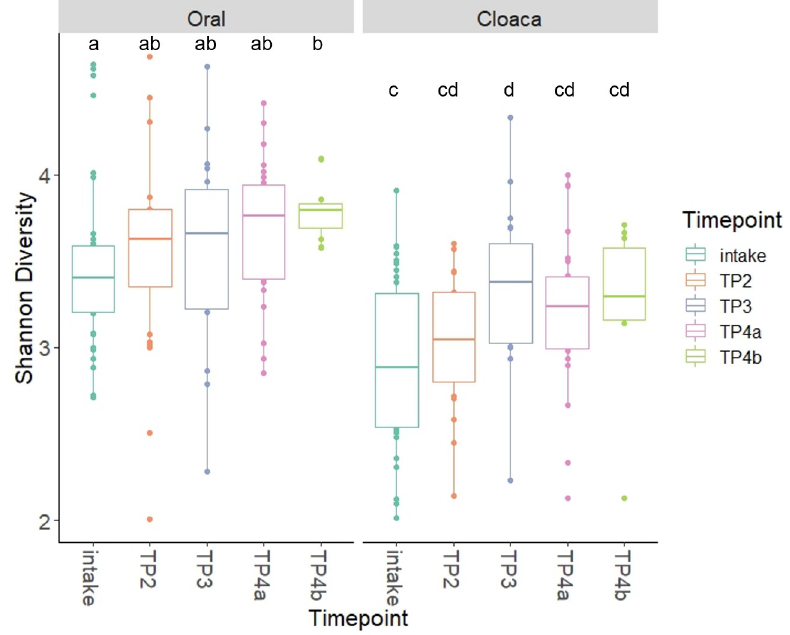
Fig 4. Shannon diversity index of turtles through rehabilitation. Oral samples (left) and cloacal samples (right) at each timepoint during rehabilitation. Different letters above boxplots indicate significant differences in means of Shannon diversity (p < 0.05; S2 Table).